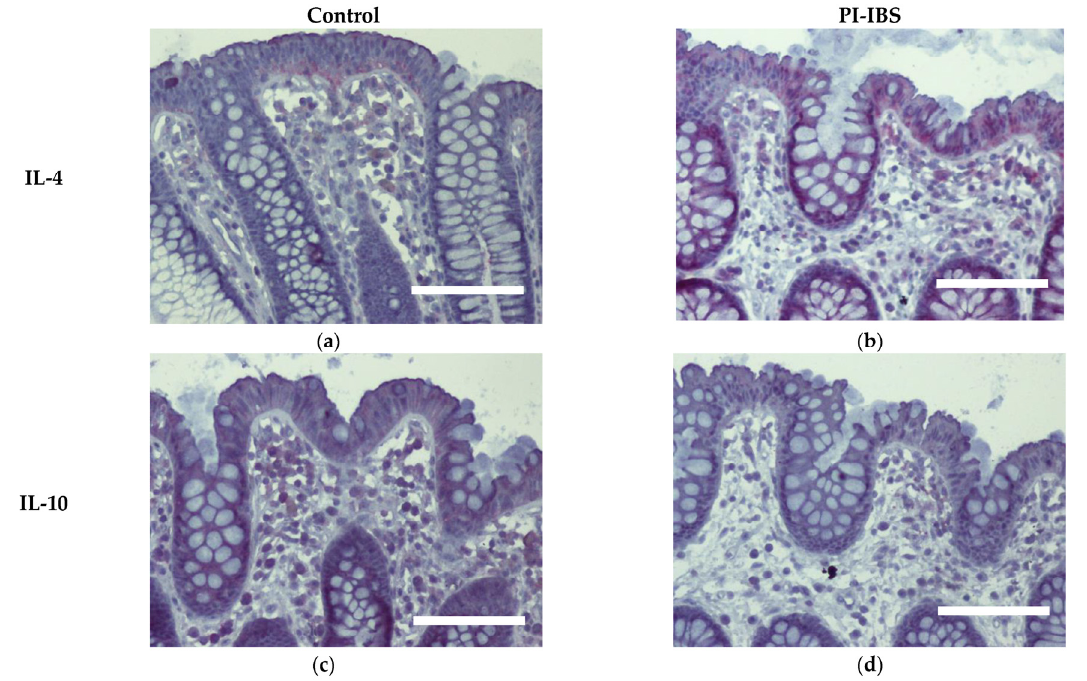
Figure 6. Immunohistochemistry of the Th2 cytokines IL-4 and IL-10 (red) in the colon mucosa of controls ( a , c ) and PI-IBS patients ( b , d ) (counterstaining with hematoxylin = violet). Staining for IL-4 intensified in surface enterocytes in PI-IBS. Bar = 100 µm.